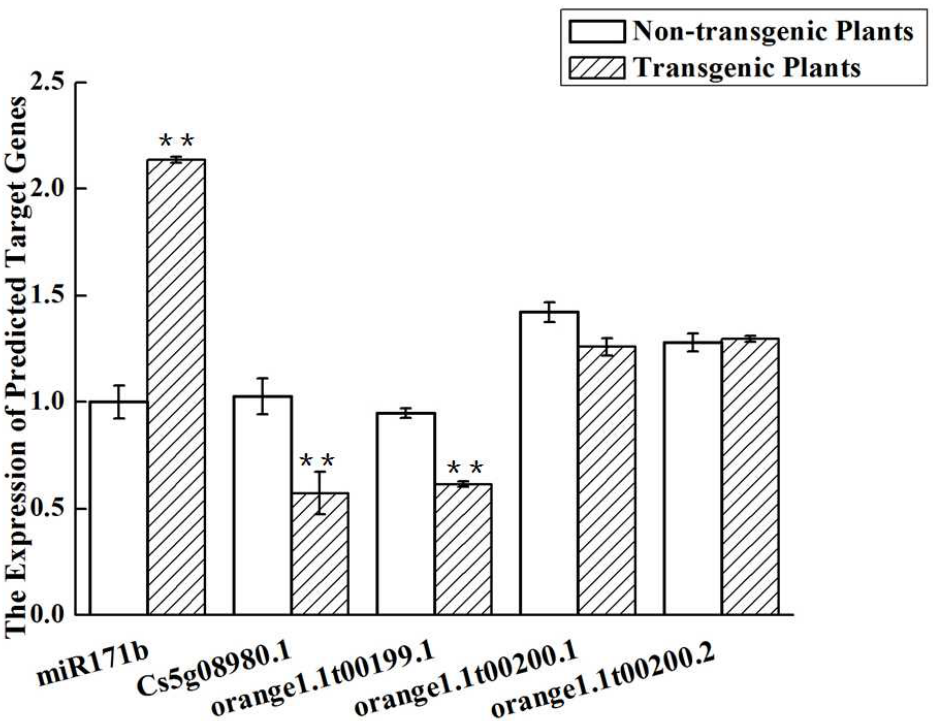
Figure 12. The expression level of the predicted target genes for miR71b. Experiments were repeated twice with similar results. ** indicates p values of <0.01 compared with the non-transgenic